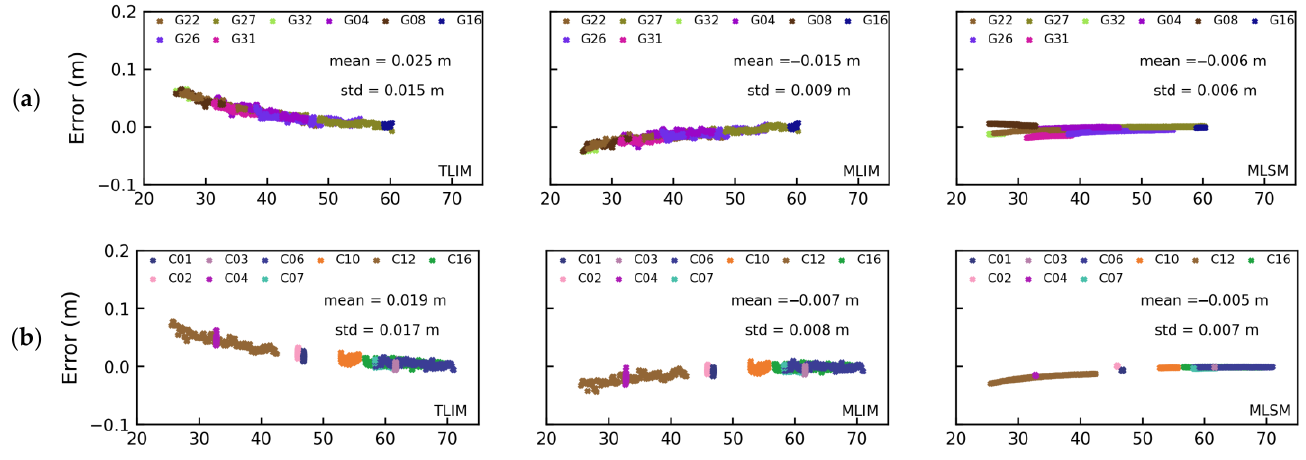
Figure 9. TLIM ( left ), MLIM ( middle ), and MLSM ( right ) change trend of DD tropospheric errors with changes in elevation angle for GPS satellites ( a ) and BDS satellites ( b ).